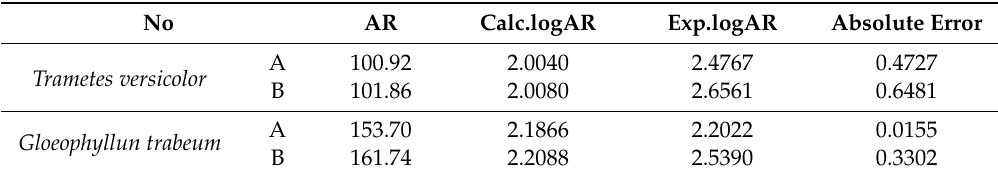
Table 7. Antifungal activity ratios of designed compounds.